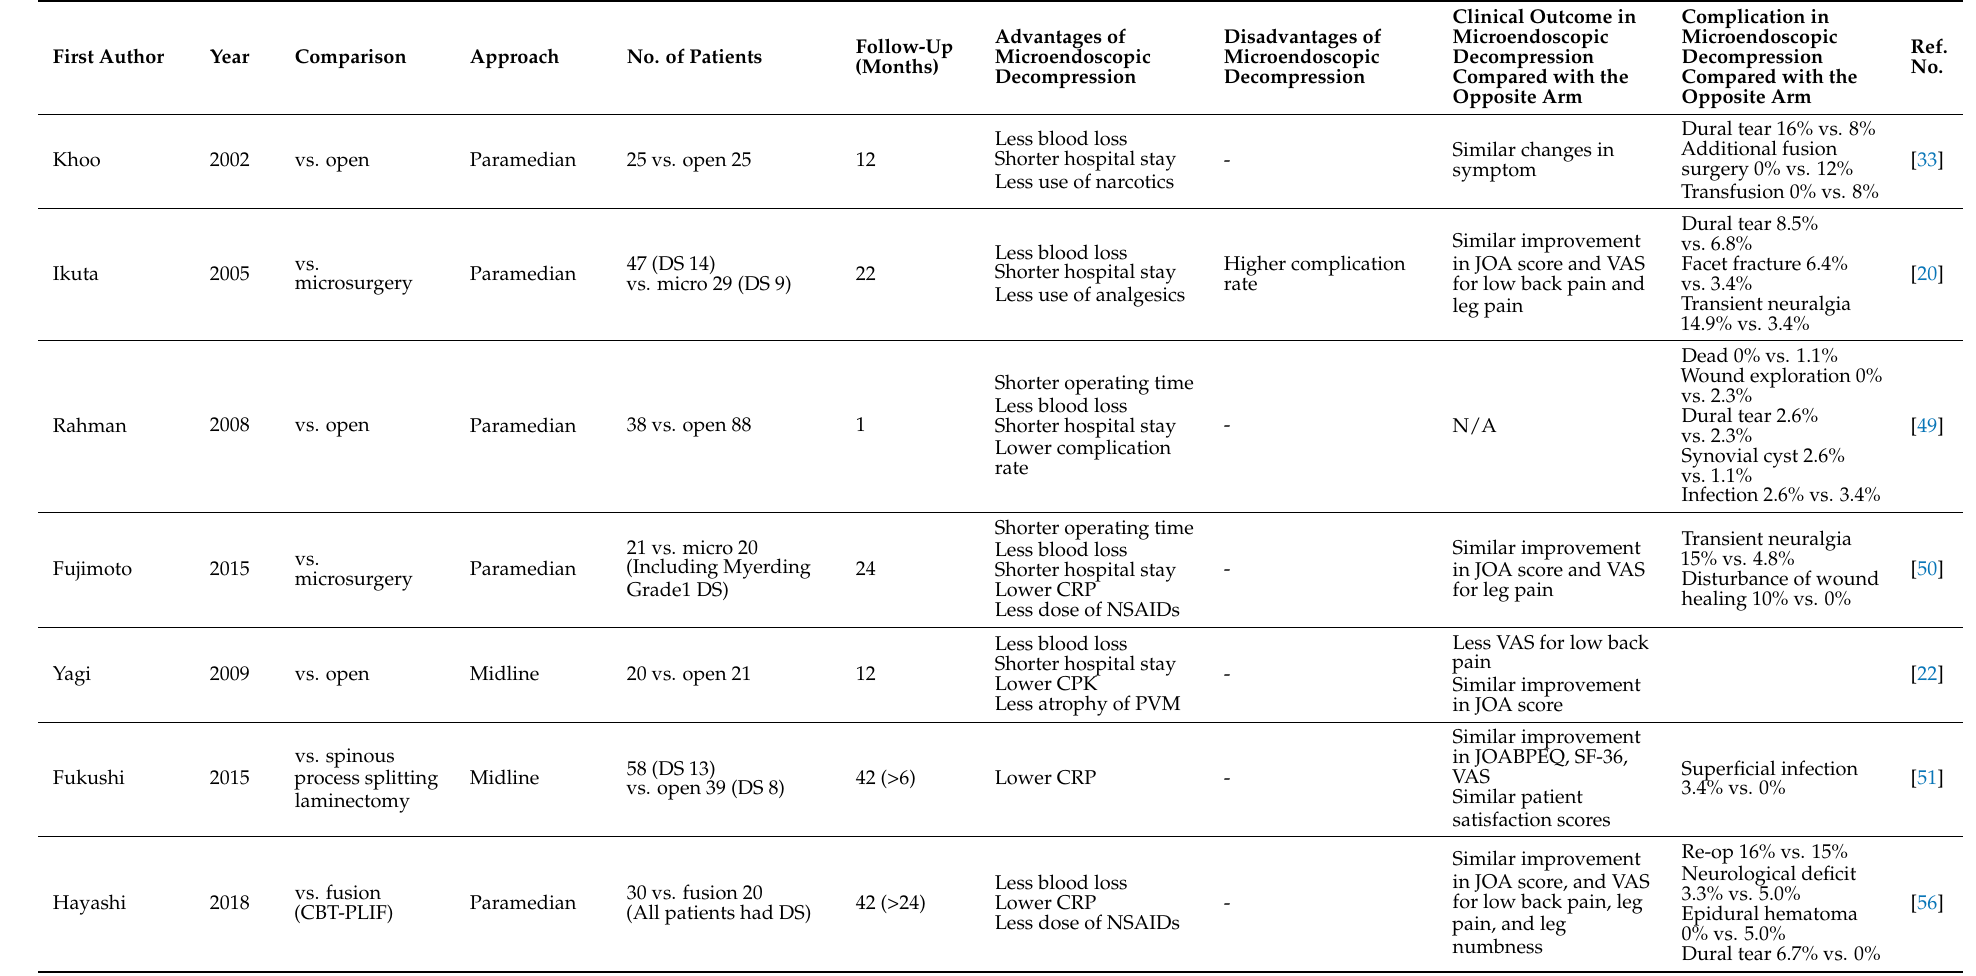
Table 1. Comparison of clinical outcomes between microendoscopic decompression and other surgical